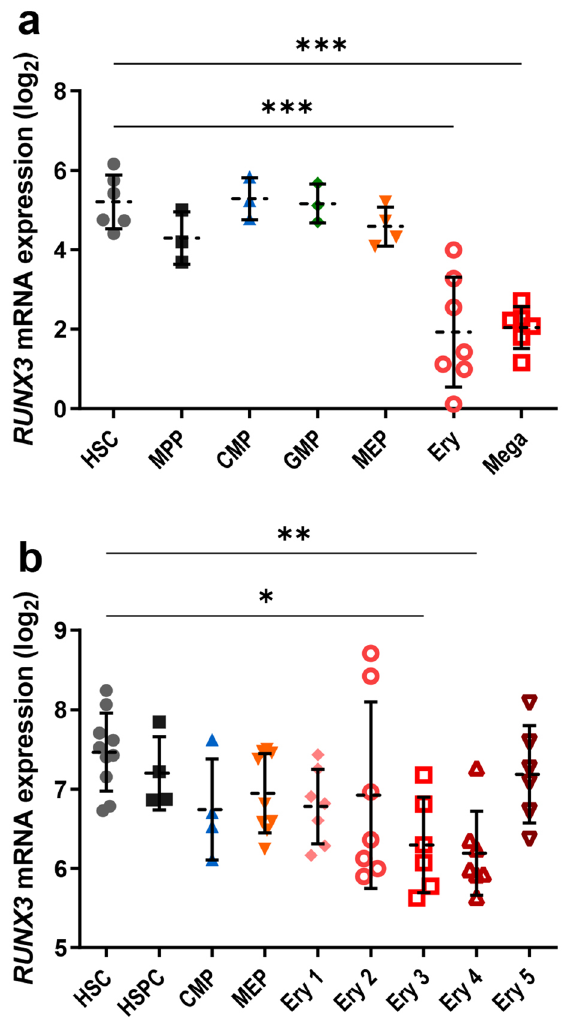
Figure 1. RUNX3 mRNA expression levels decrease during normal human erythropoiesis. ( a ) RUNX3 mRNA expression (log 2 transformed) within distinct human haematopoietic cell subsets. MPP—Multipotent progenitor; GMP—Granulocyte/monocyte progenitor; Ery—Erythroblast; Mega—Megakaryocytic cell CD34 − CD41 + . RNA-sequencing data obtained from the BLUEPRINT study 43 . Data indicate mean ± 1SD (n ≥ 3). Statistical analysis was performed using ANOVA with Tukey’s multiple comparisons test, *** p < 0.001 vs HSC. ( b ) RUNX3 mRNA expression (log 2 transformed) in distinct haematopoietic cell subsets based on cell surface marker expression. HSC—Haematopoietic stem cell CD133 + CD34 dim ; HSPC—Haematopoietic stem progenitor cell CD38 − CD34 + ; CMP—Common myeloid progenitor; MEP—Megakaryocyte/erythroid progenitor; Ery